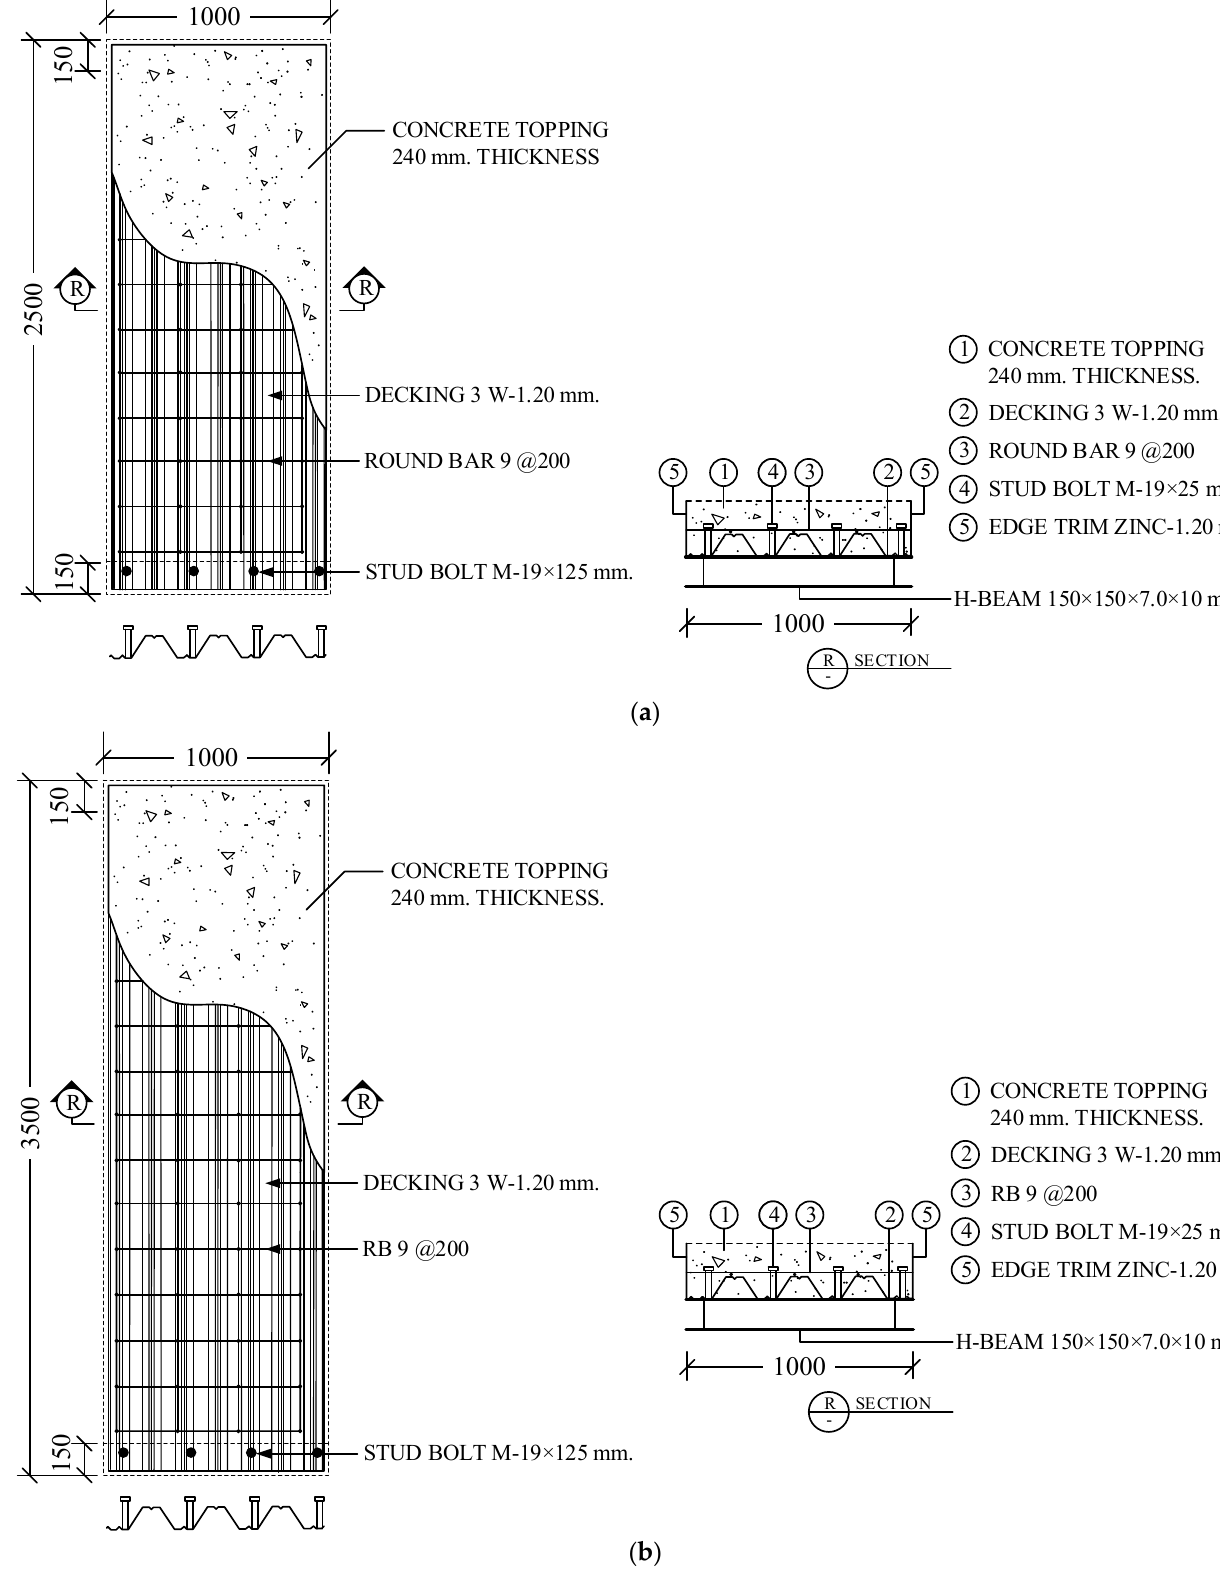
Figure 1. Details of test composite decks. ( a ) Specimens S1 and S2 (dimensions in mm). ( b ) Specimens S3 and S4 (dimensions in mm).